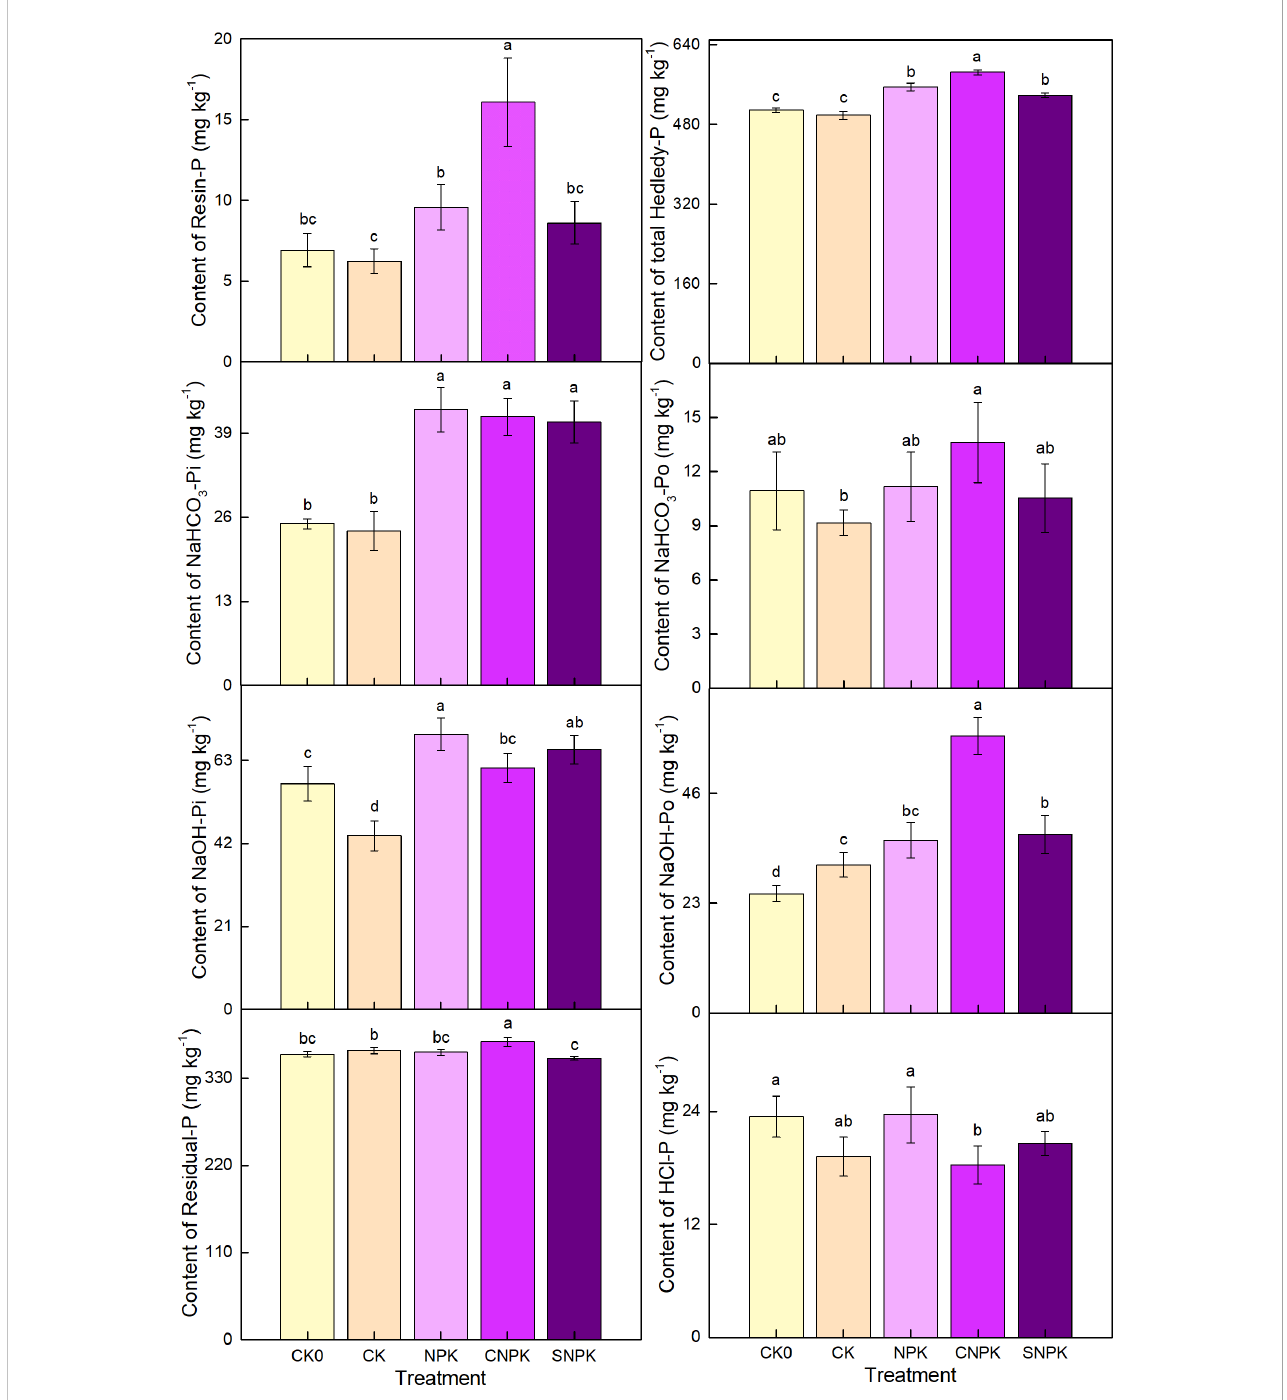
FIGURE 3 Effects of the different treatments on soil P fractions in the Hedley improvement method (1993). Error bars represent standard deviation, n = 3. Different letters in a column indicate signi fi cant differences at the 0.05 level. Resin-P: resin exchanged P; NaHCO 3 -Pi and NaHCO 3 -Po: NaHCO 3 extracted state inorganic P and organic P; NaOH-Pi and NaOH-Po: NaOH extracted state inorganic P and organic P; HCl-P: 1 mol L dilute hydrochloric acid to extract P; and Residual-P: residual P. CK0: initial soil; CK: non-fertilizer; NPK: NPK fertilizer; CNPK: biochar + NPK fertilizer; SNPK: corn stover + NPK